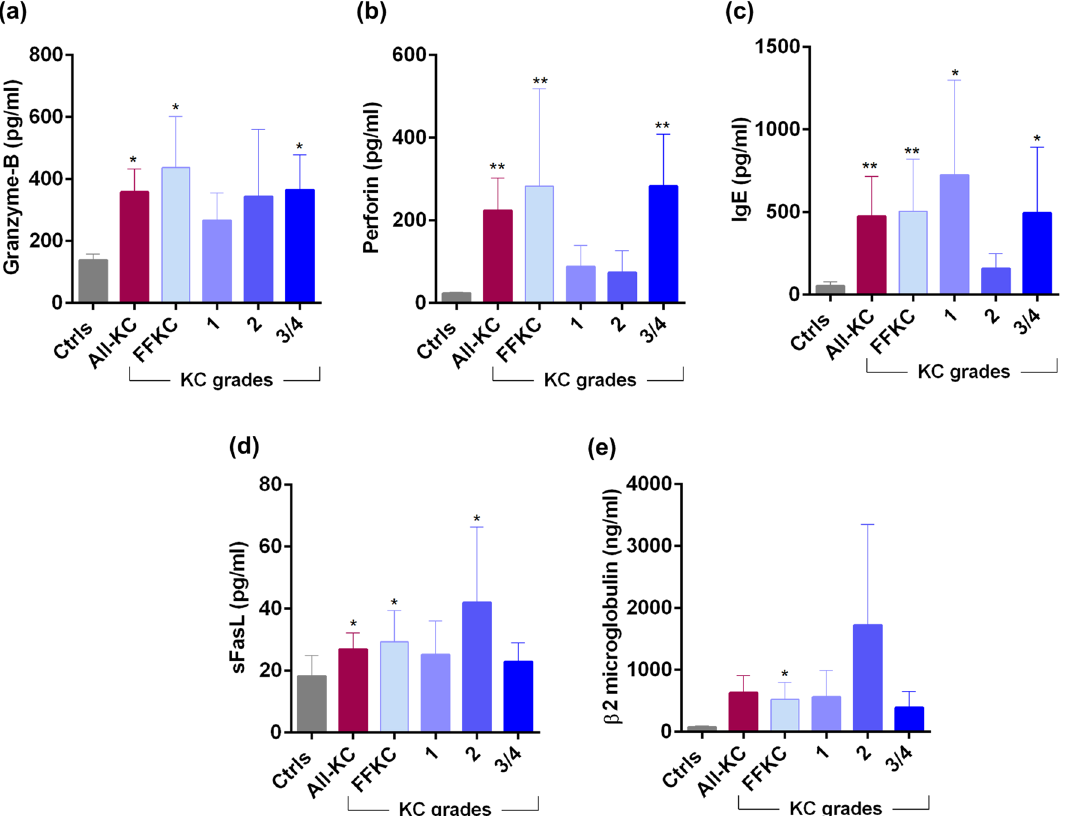
Figure 8. Tear fluid secreted factors level in KC patients: The graphs indicate the concentration of granzyme-B ( a ), perforin ( b ), IgE ( c ), sFasL ( d ) and β2 microgloublin ( e ) in the tear fluid of subjects with different grades of KC. Ctrls—Controls; All-KC—all the grades of keratoconus combined; FFKC—Forme fruste keratoconus; IgE— immunoglobulin E; sFasL—soluble Fas ligand; SEM—standard error of the mean; Controls (20 eyes), All-KC (41 eyes), FFKC (6 eyes), grade 1 KC (6 eyes), grade 2 KC (6 eyes), grade 3 or 4 (23 eyes); Bar graphs represent Mean ± SEM; *P < 0.05, **P < 0.01, Mann–Whitney test.